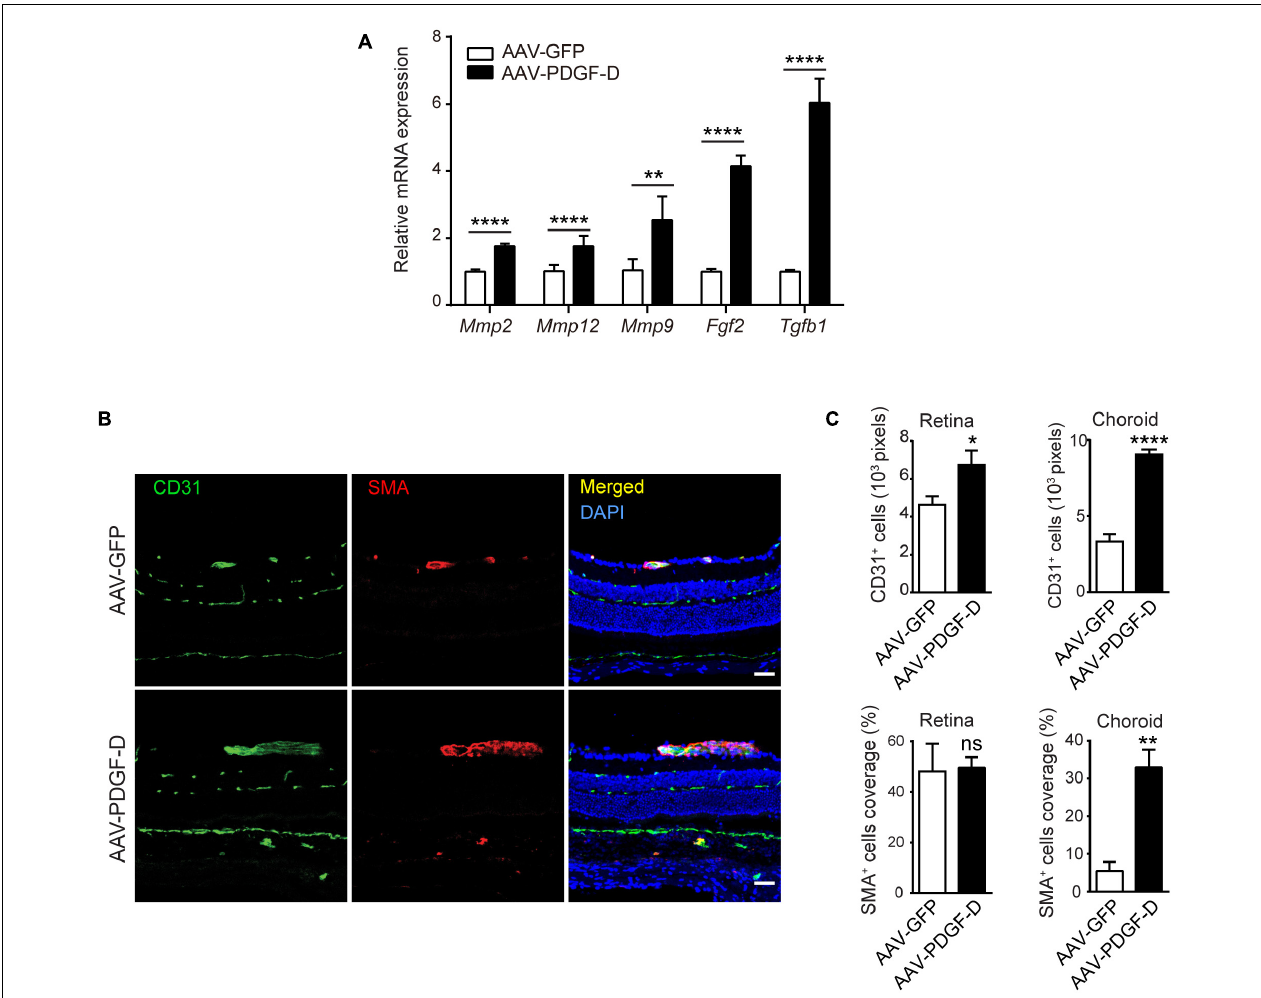
FIGURE 5 | PDGF-D overexpression increased vascular endothelial cell density and mural cell coverage in mouse retinae and choroids. (A) Real-time PCR results showing angiogenic genes upregulated by PDGF-D overexpression in RPE-choroid complex. (B) Immunofluorescence staining of CD31 + endothelial cells (EC) and α -SMA + smooth muscle cells (SMC) in mouse retinae and choroids injected with AAV-GFP or AAV-PDGF-D. (C) Quantifications of CD31 + cell density and SMC coverage in retinae and choroids in (B) . Scale bar: 50 µ m. n = 5, * p < 0.05, ** p < 0.01, **** p < 0.0001, ns: not